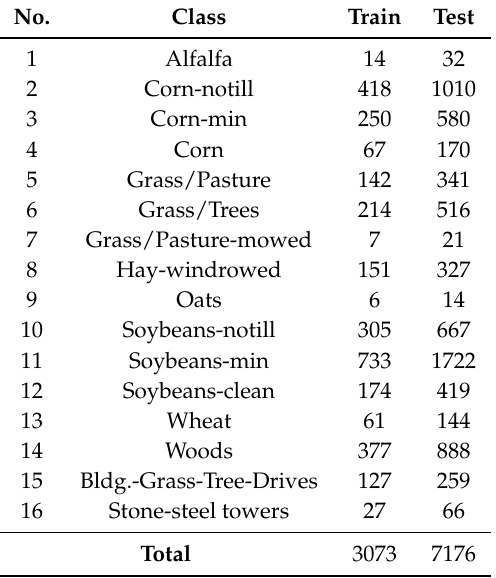
Table 1. The number of training and testing samples for the Indiana dataset.